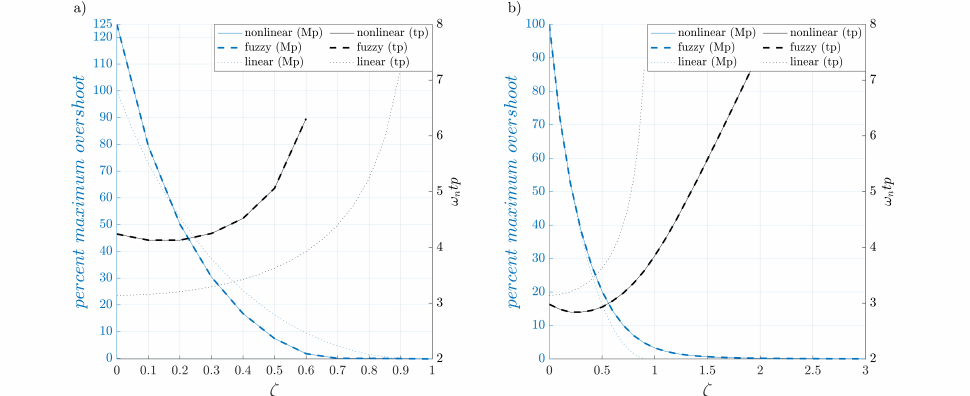
Figure 17. The result for dilation graphs shows the per cent overshoot and normalised peak time as a function of damping ratio ζ ; ( a ) step-up, ( b )